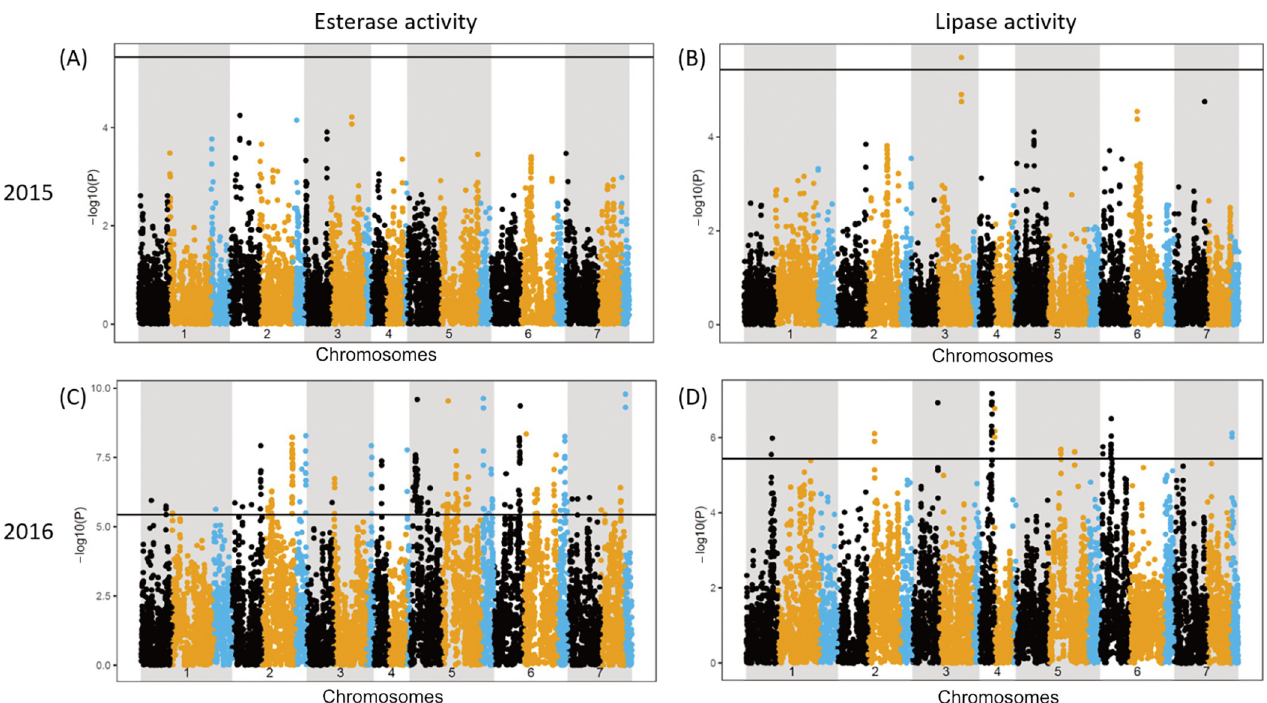
Fig 2. Manhattan plots for esterase (A, C) and lipase (B, D) activity of the GABI-panel harvested in 2015 (A, B) and 2016 (C, D). The x-axis shows the relative position across 7 chromosomes and the y-axis the -log 10 P-value. The three genomes, A, B and D, are represented by black, orange and blue, respectively. Significant line is drawn at FDR p =